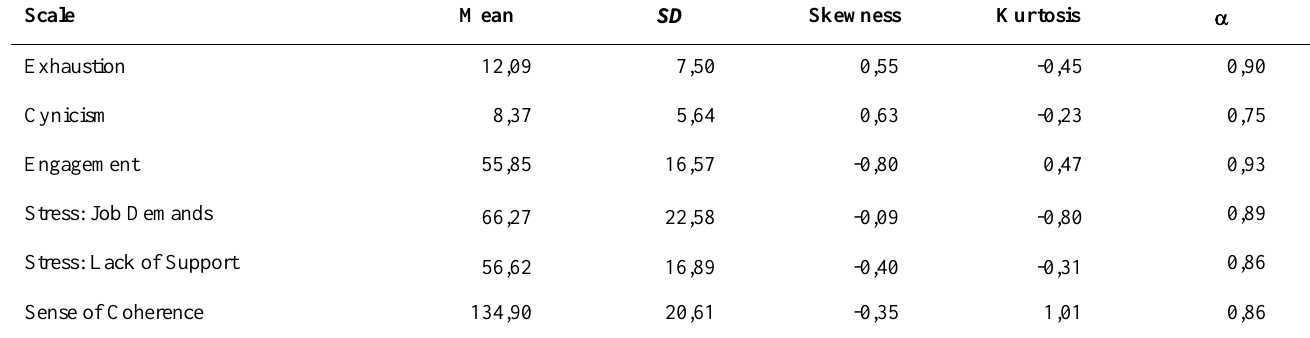
Table 1: Descriptive statistics and alpha coefficients of the MBI-GS, UWES, JSI and OLQ Scale